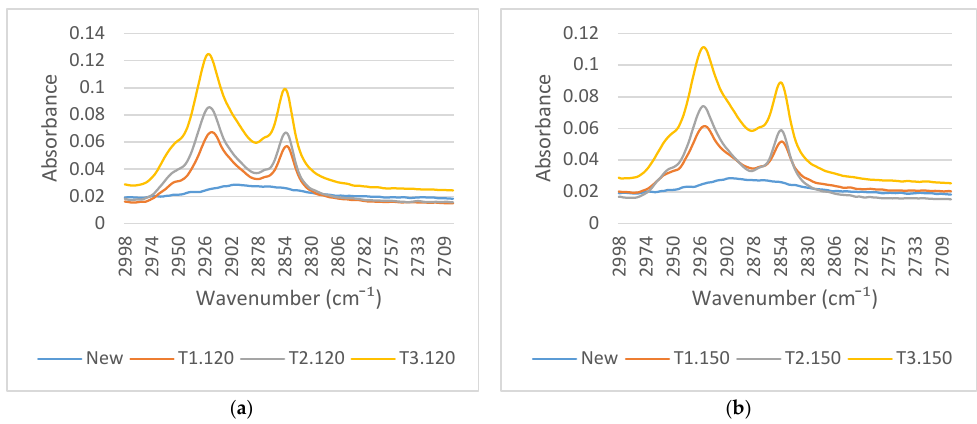
Figure 8. FTIR spectra at wavenumber 3000–2700 cm −1 of transformer insulation paper at aging temperature ( a ) 120 °C and ( b ) 150 °C.